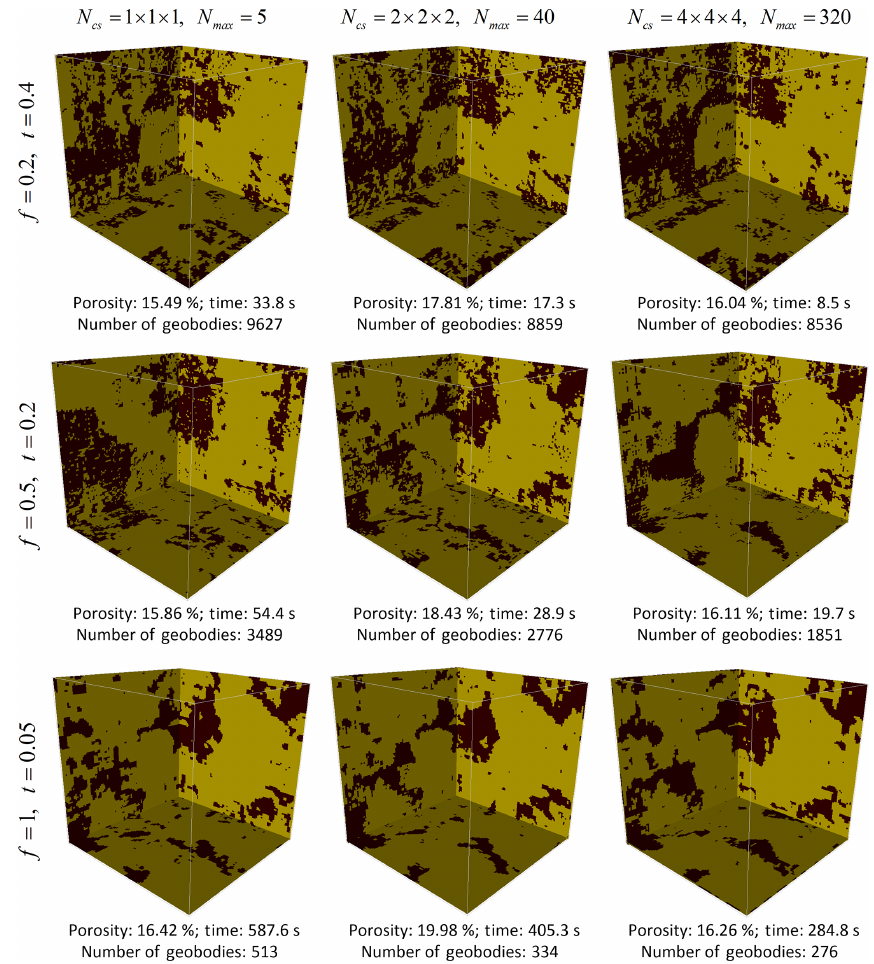
Figure 8. Interaction between t , f , N cs and N max . These first sections in three directions of each realization are presented. The porosity, CPU time and the number of geobodies are the average of 10